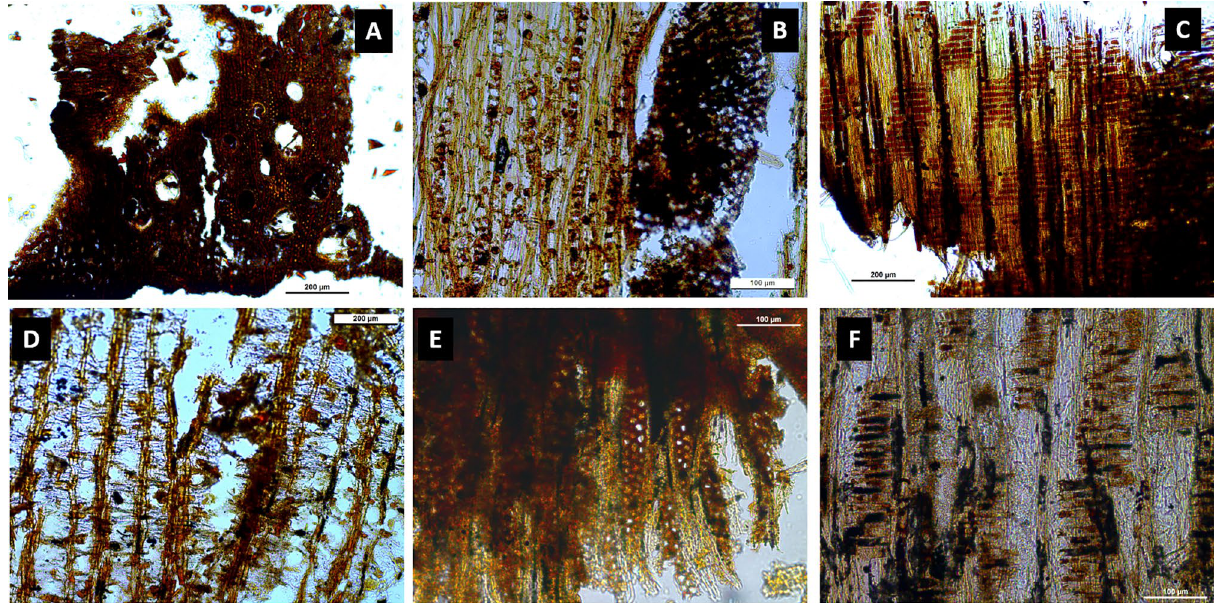
Figure 5. ( A ) Sample from the transversal section of deciduous Quercus sp.; ( B ) sample from the tangential section of deciduous Quercus sp.; ( C ) sample from the radial section of deciduous Quercus sp.; ( D ) sample from the transversal section of Rosaceae / Maloideae ; ( E ) sample from the tangential section of Rosaceae / Maloideae ; ( F ) sample from the radial section of Rosaceae / Maloideae